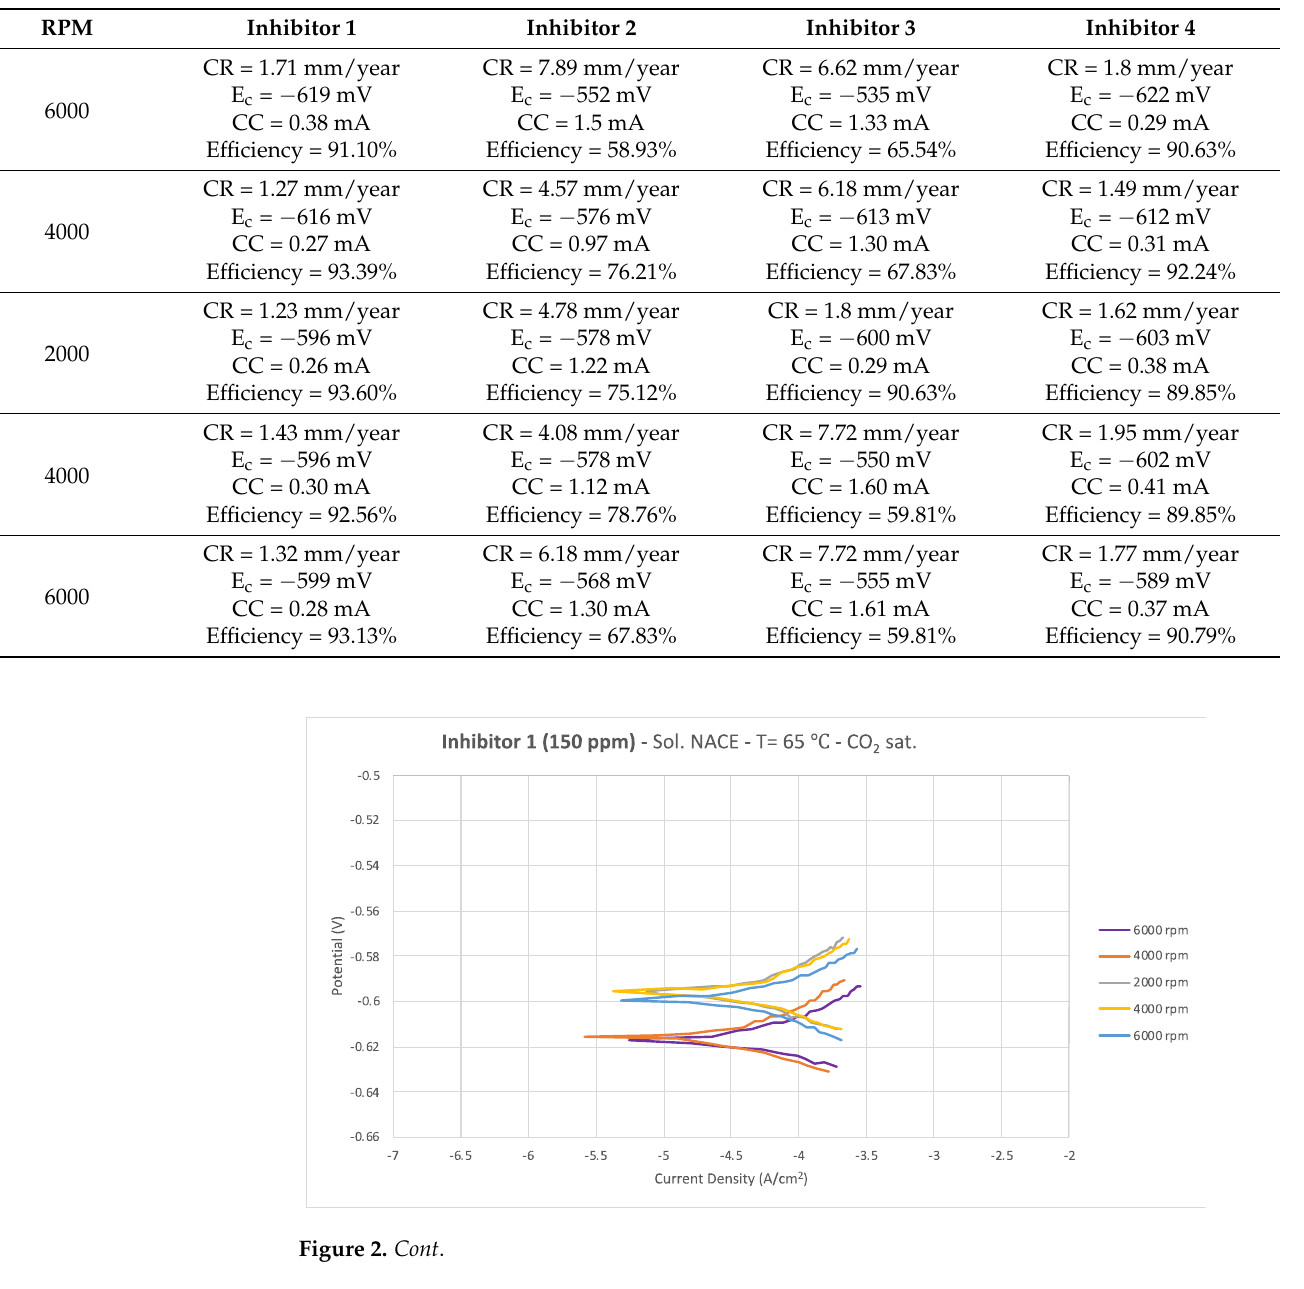
Table 1. Polarization resistance essays in a rotating cylinder in a NACE solution. Corrosion rate (CR) and inhibitor’s efficiency with respect to the general